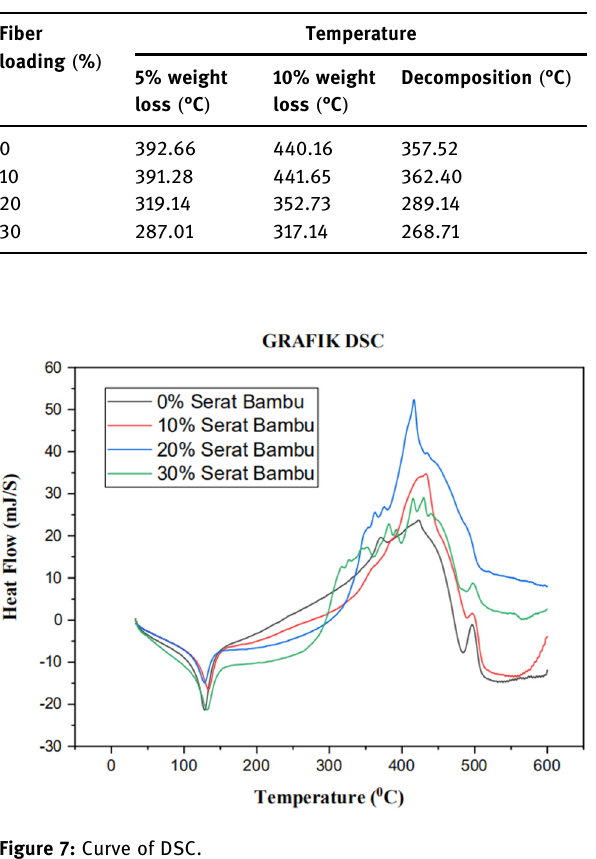
Table 1: Thermal stability of r - HDPE/bamboo composite